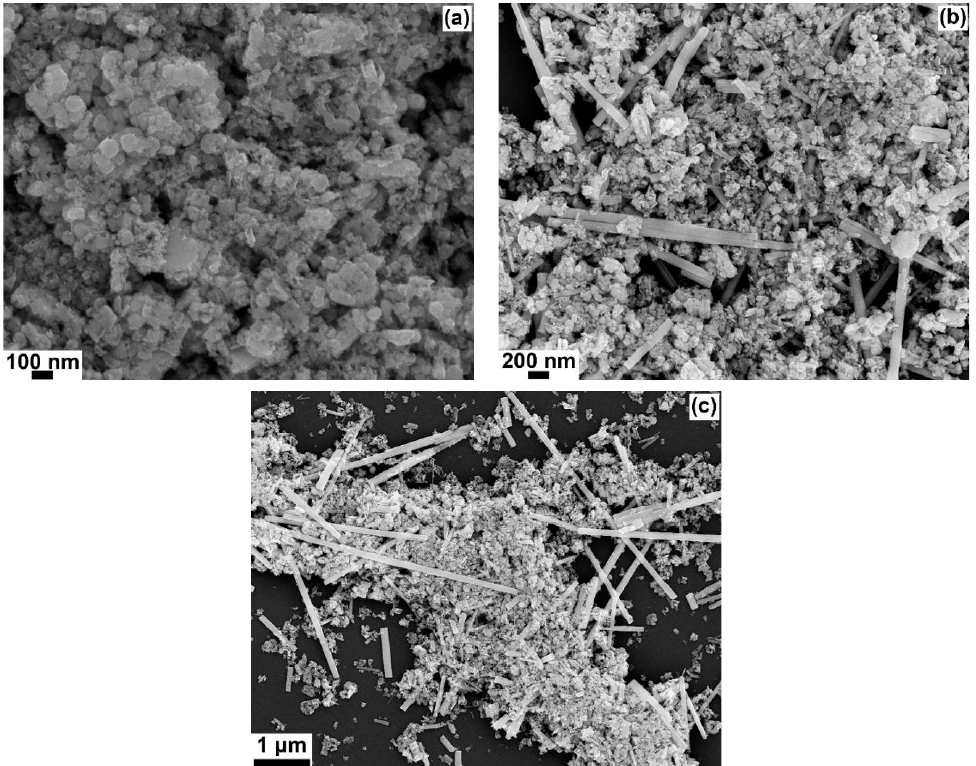
Figure 6. The SEM images of the samples synthesized hydrothermally at 200 °C using 0.18 mmol CsCl, 0.4 mmol WO 3 , 8.8 mmol CH 3 CH 2 CHO, 2.8 mmol NH 3 · H 2 O and 5 mmol (NH 4 ) 2 SO 4 and for ( a ) 4 h; ( b ) 12 h; ( c ) 20 h.